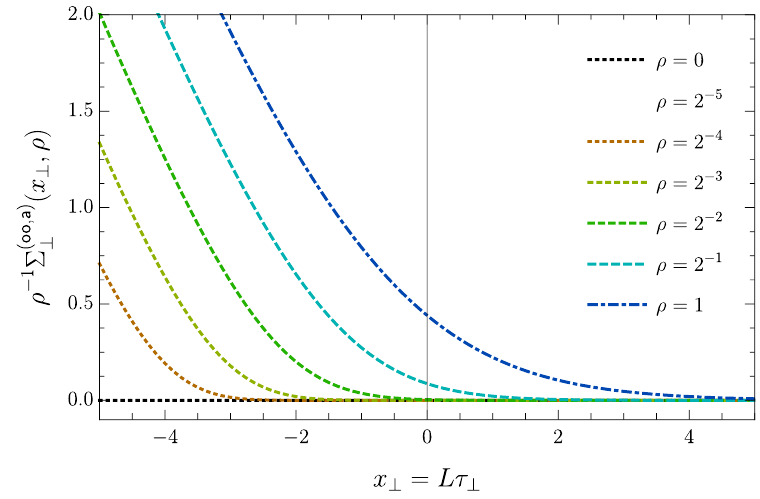
( oo , a ) ( x ρ ) for different values of the aspect ratio ⊥ , ⊥